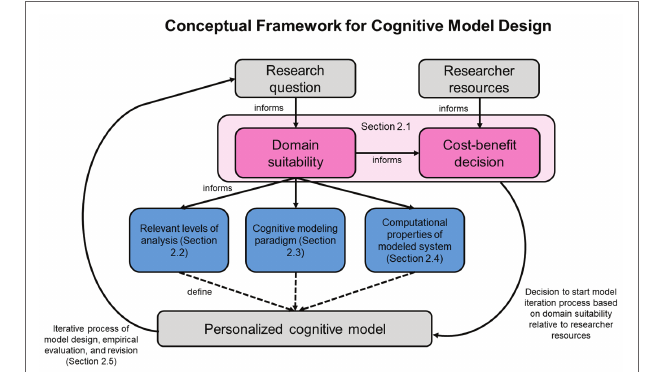
FIGURE 2 | Conceptual framework for cognitive model design. External aspects are displayed in gray, and pink indicates initial considerations that inform the specific design decisions, which are themselves colored blue. The framework is used by evaluating domain suitability and available resources to reach a decision on whether to initiate the modeling process. Then, model- related aspects are defined and the resulting model is empirically evaluated. If necessary, an iterative process of model improvement is